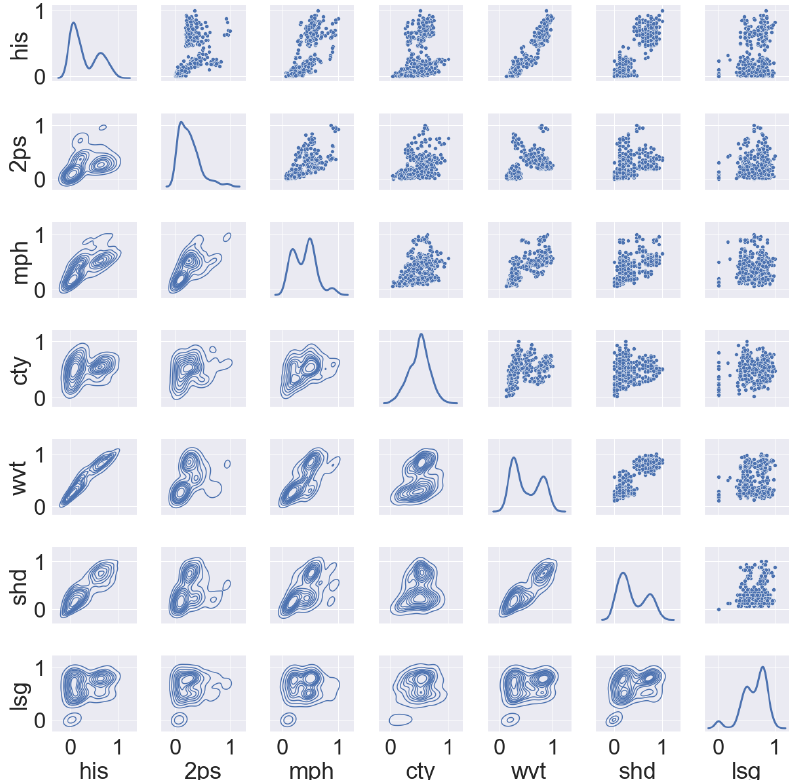
Figure 18. Comparison of global normalised dissimilarity measures for an ensemble of 30 scalar field 3D voxets across 3 scenarios; cross- plots and density plots by pairs of normalised dissimilarity measures; his – histogram, 2ps – semi-variogram, mph – multiple-point histogram, cty – connectivity, wvt – wavelet decomposition coefficients, shd – topological structural Hamming distance, lsg – topological Laplacian spectral